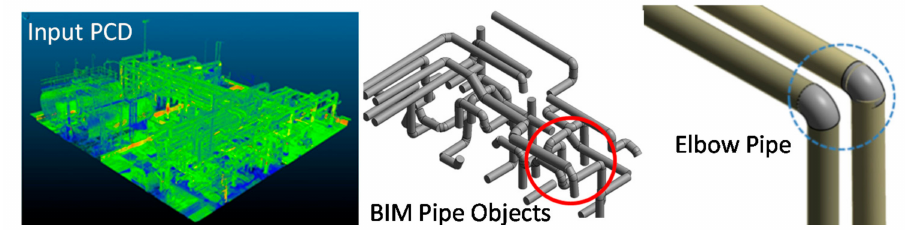
Figure 12. Elbow-Type Pipe Object Mapping Results.